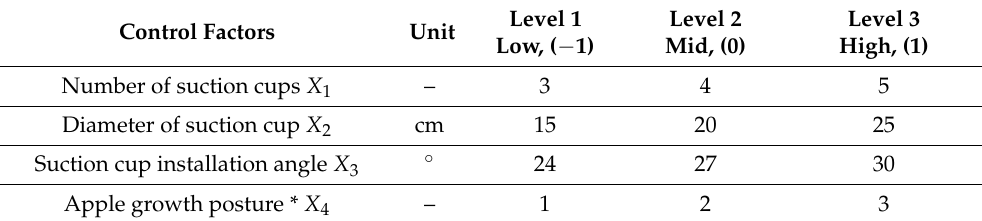
Table 5. Levels of control factors.